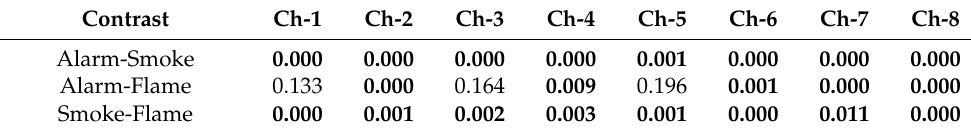
Table 16. p -values of activation